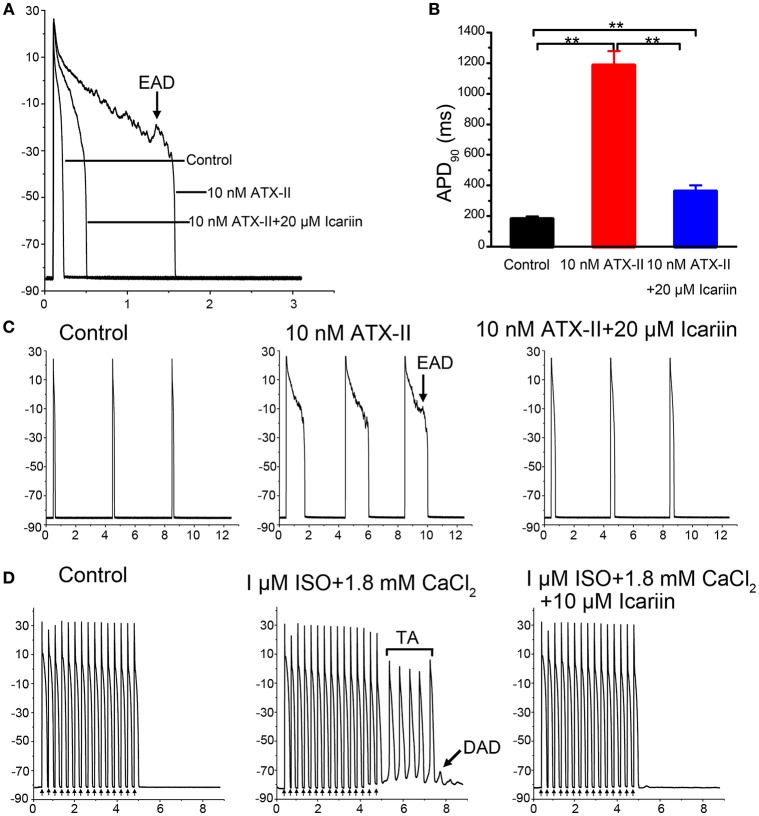
Effects of icariin on EADs and DADs, as well as TAs, in LVMs. (A,C). Administration of 20 μM Icariin completely abolished the EADs and attenuated the AP prolongations induced by 10 nM ATX-II at a stimulation frequency of 0.25 Hz. Single beats or 3 consecutive beats are displayed in (A,C), respectively. (B) Summary data for APD90 after sequential administration of 10 nM ATX-II and 20 μM icariin. **p < 0.01. (D). DADs and TAs were induced in LVMs by a baseline pacing CL of 9,000 ms and on top of that 15 beats with a stimulation frequency of 2.5 Hz after superfusion with ISO (1 μM) and a high extracellular calcium concentration ([Ca2+]o, 3.6 mM). Administration of 10 μM icariin significantly suppressed the DADs and completely abolished the TAs induced by ISO and calcium.